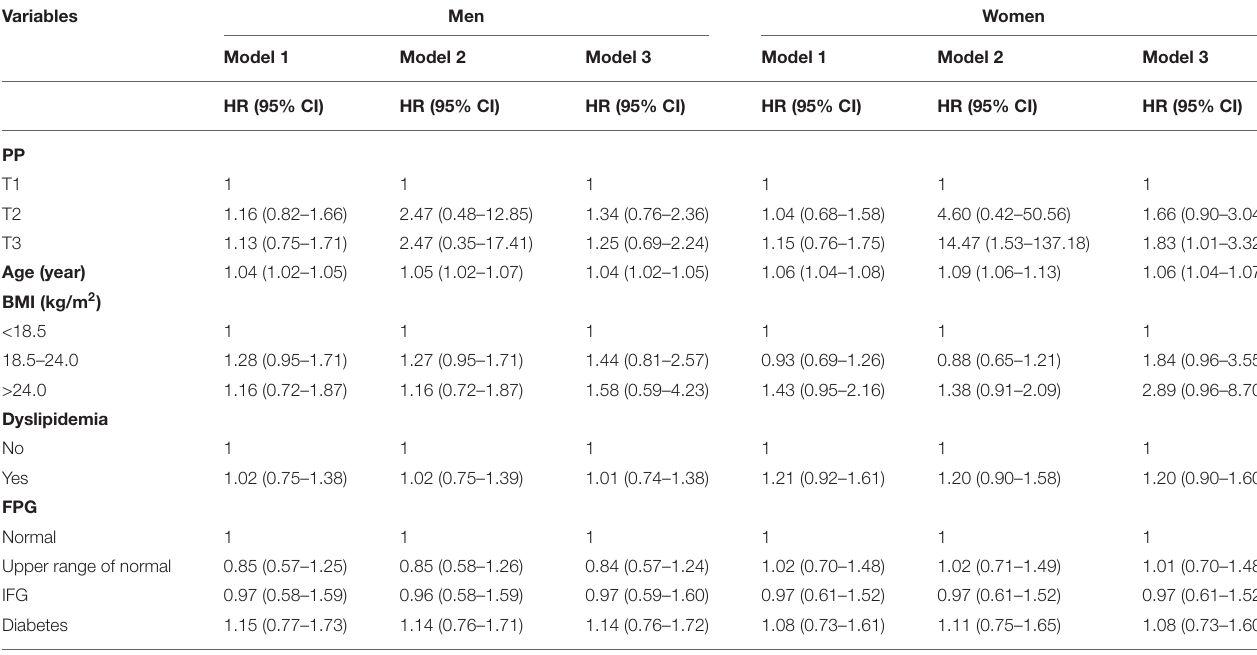
TABLE 5 | Analysis of variables that may affect the association between pulse pressure (PP) tertile and risk of carotid plaque.